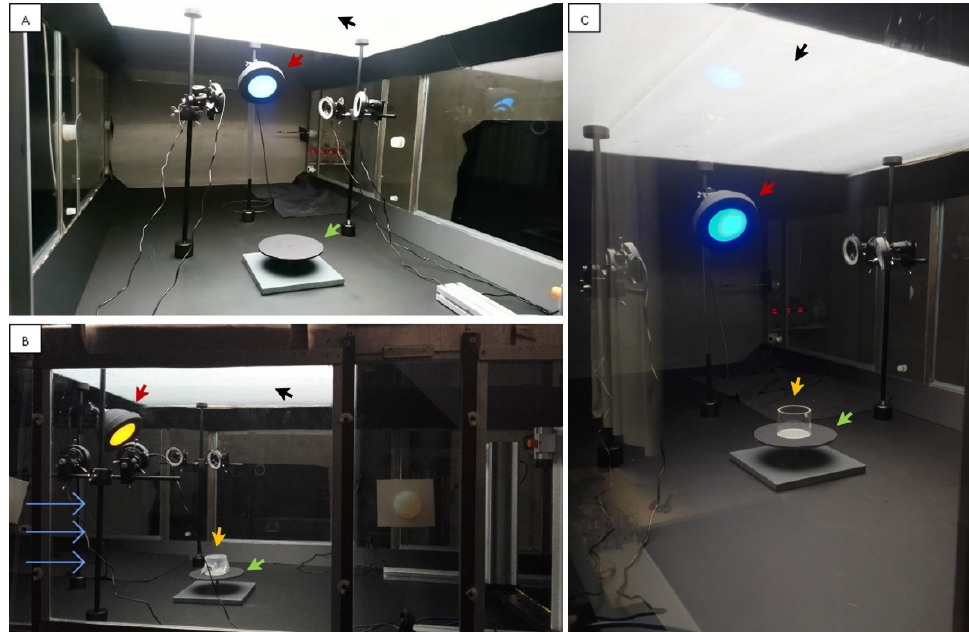
Figure 2. The wind tunnel setup used for the WFT behavioural experiments viewed from different perspectives illustrating: ( A ) The complete equipment arrangement; ( B ) the yellow stimulus, release container and wind direction; ( C ) the release container in relation to the LED stimulus (blue). Red arrow, LED lamp (dome); green arrow, insect release platform; yellow arrow, insect release container; blue arrows, wind direction inside the wind tunnel; black arrow, general ceiling illumination provided for the wind tunnel (includes wavelengths in the visible light spectrum and UV-A light).